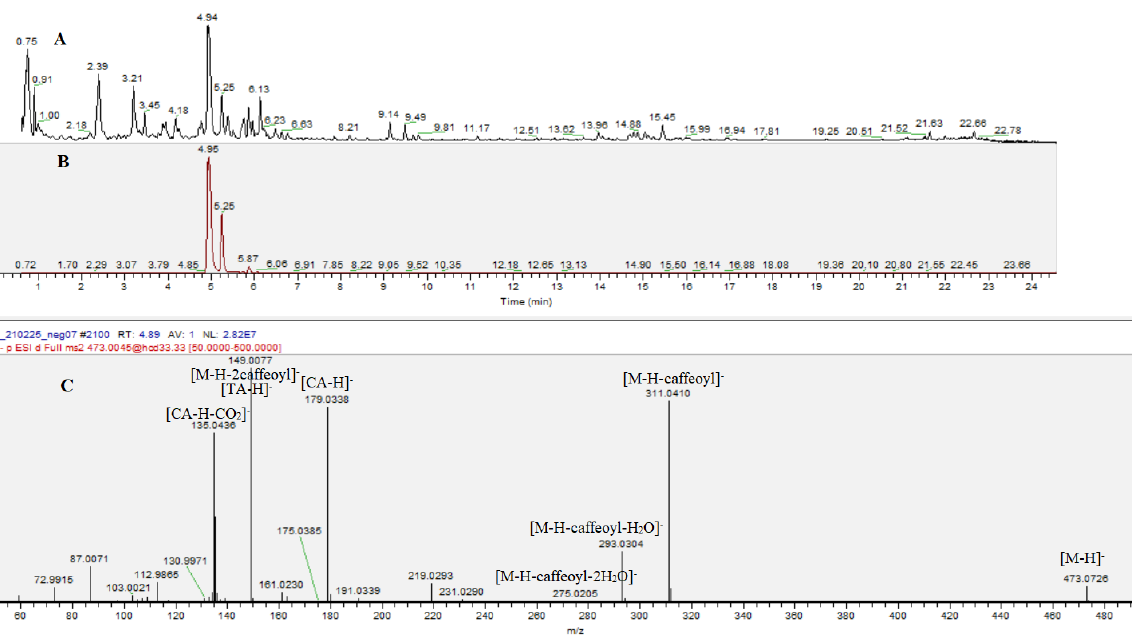
Figure 1. Total ion chromatogram (TIC) in negative ion mode of C. alpina leaves extract ( A ); extracted ion chromatogram of peaks at m/z 473.072 ( B ); (−) ESI/MS-MS spectrum of dicaffeoyltartaric acid ion chromatogram of peaks at m/z 473.072 ( B ); ( − ) ESI/MS-MS spectrum of dicaffeoyltartaric acid (cichoric acid) ( 47 ) ( C ). (cichoric acid) ( 47 ) ( C